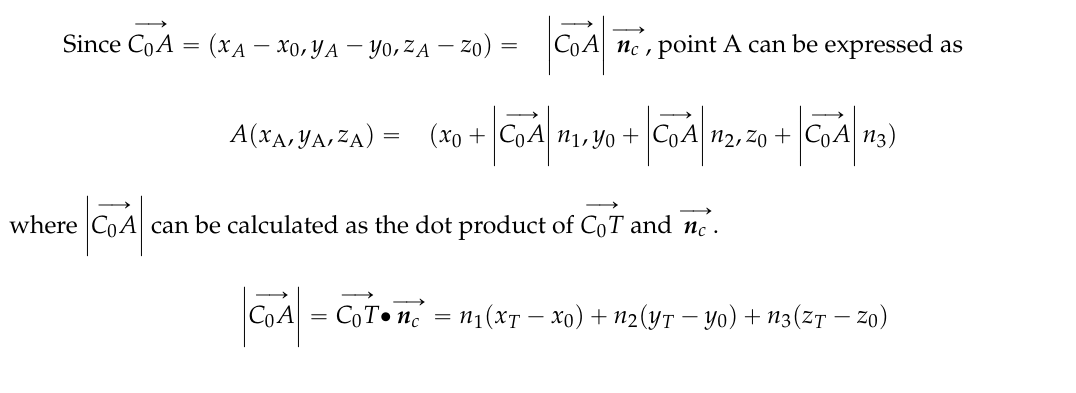
Figure 6. Uncertainty evaluation for a given critical point.